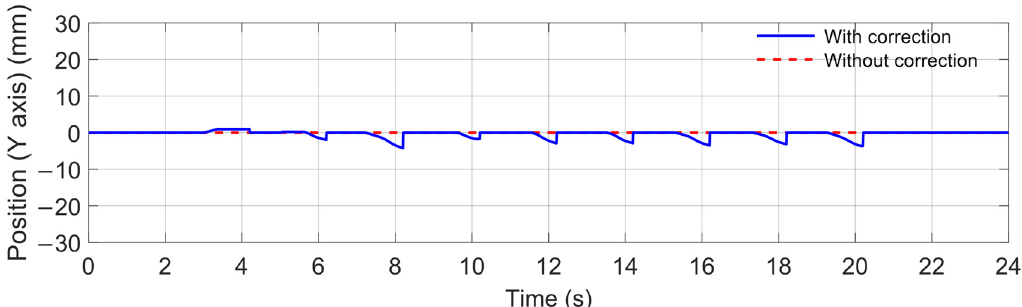
Figure 15. Comparison of ideal foot trajectory in Y direction of leg 1 with and without correction.